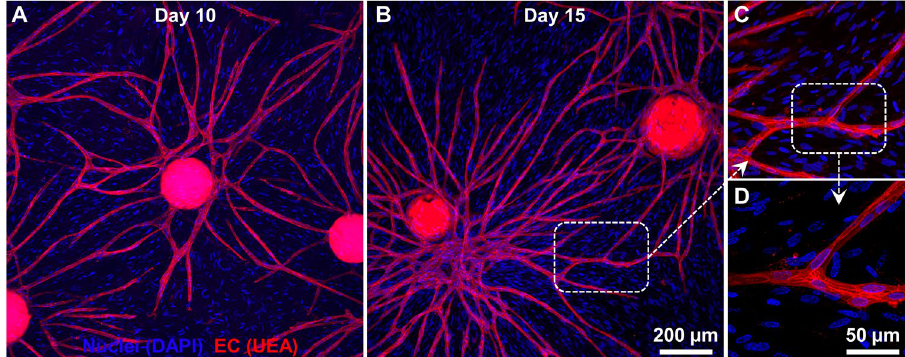
Figure 7. Vascular anastomoses and endothelial network formation. ( A ) Confocal stacks showing the endothelial sprouts from microgel at day 10. The endothelial cells are stained with Ulex Europaeus Agglutinin I (UEA), and nuclei are stained with DAPI. ( B ) By Day 15, the endothelial sprouts grew radially and anastomosed with the neighboring microgels to form a diffuse vascular network. ( C , D ) Higher magnification confocal stacks showing vascular anastomoses between the neighboring microgels. The nuclei of the perivascular fibroblasts were visible with DAPI blue stain.